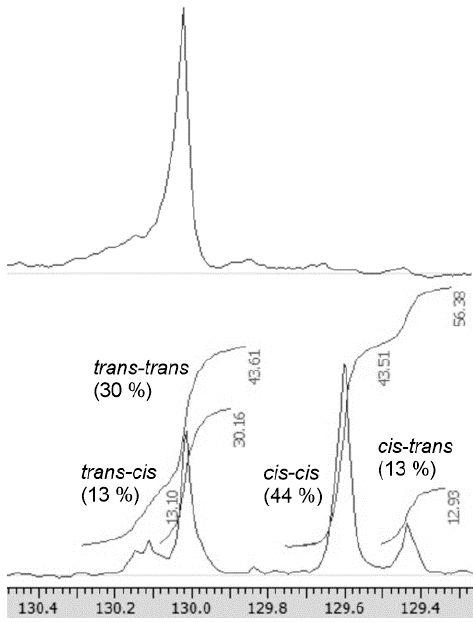
Figure 5. 13 C NMR spectrum (125 MHz, in CDCl 3 ) of trans -1,4 prepolymer ( above ) and stereodiblock polybutadiene synthesized in Scheme 2 ( below ).